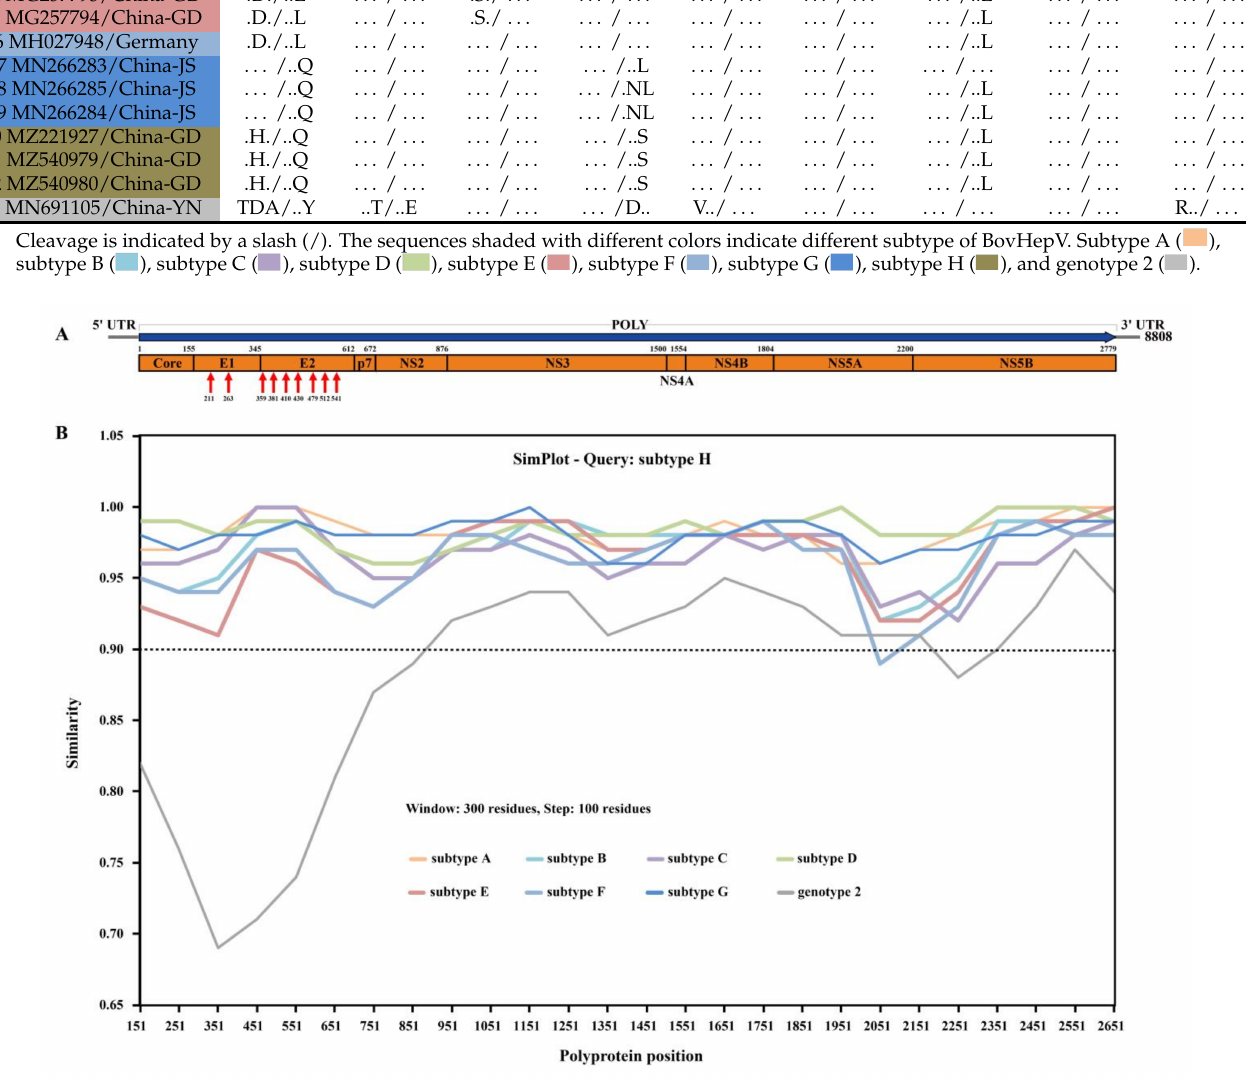
Figure 2. Genomic characterization of bovine hepacivirus. ( A ) Genome organization of BovHepV identified in this study. Red arrows indicate N-linked glycosylation sites. ( B ) Simplot analysis of BovHepV strains of subtype A-H based on polyprotein. Comparison of amino acid sequence identity of polyprotein within subtype A-H of BovHepV strains, calculated using Simplot version 3.5.1 with a sliding window of 300 and a step size of 100 residues. Different colors represent different subtypes of BovHepV. The GenBank accession numbers of the BovHepV strains of subtype A-H are listed